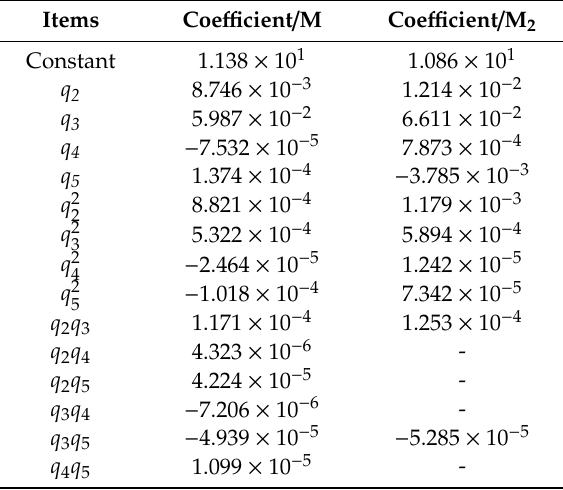
Table 4. Coe ffi cients of items in M and M 2 .